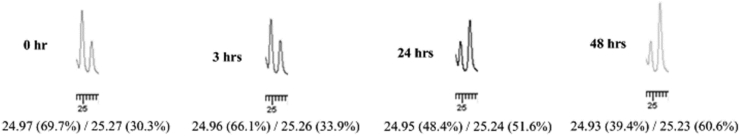
Sections of RP-HPLC chromatograms for the plasma stability study performed on the mixture containing 16 and a lower amount of 20, over time (0–48 h). tR and percentage of each peak is presented beneath each chromatogram. The full chromatograms are presented in SD (Fig. S29).